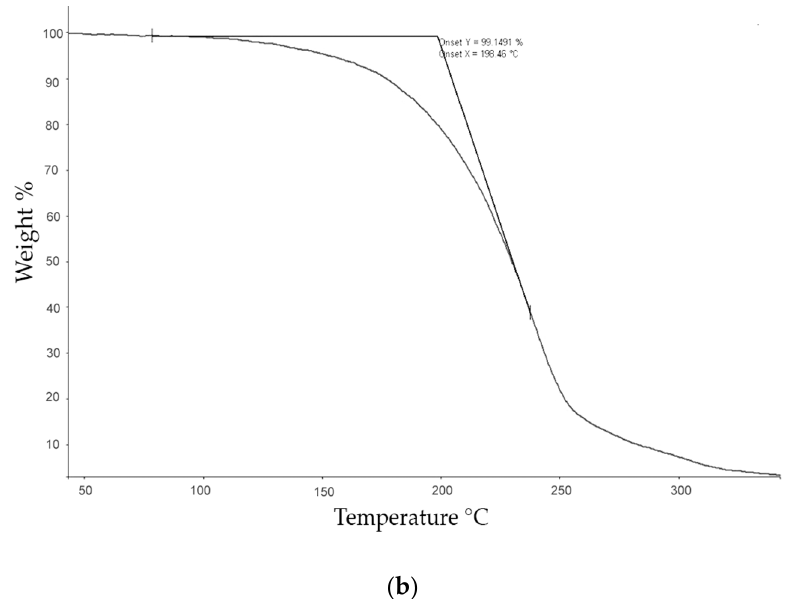
Figure 5. DSC ( a ) and TG ( b ) of compound VA4J. ( a ) Curve A: first scan (fusion of Form I) and curve B: second scan (fusion of recrystallized form); ( b ) TG of compound VA4J at 10 °C/min. Table 3. Fusion–recrystallization of compound VA4J.